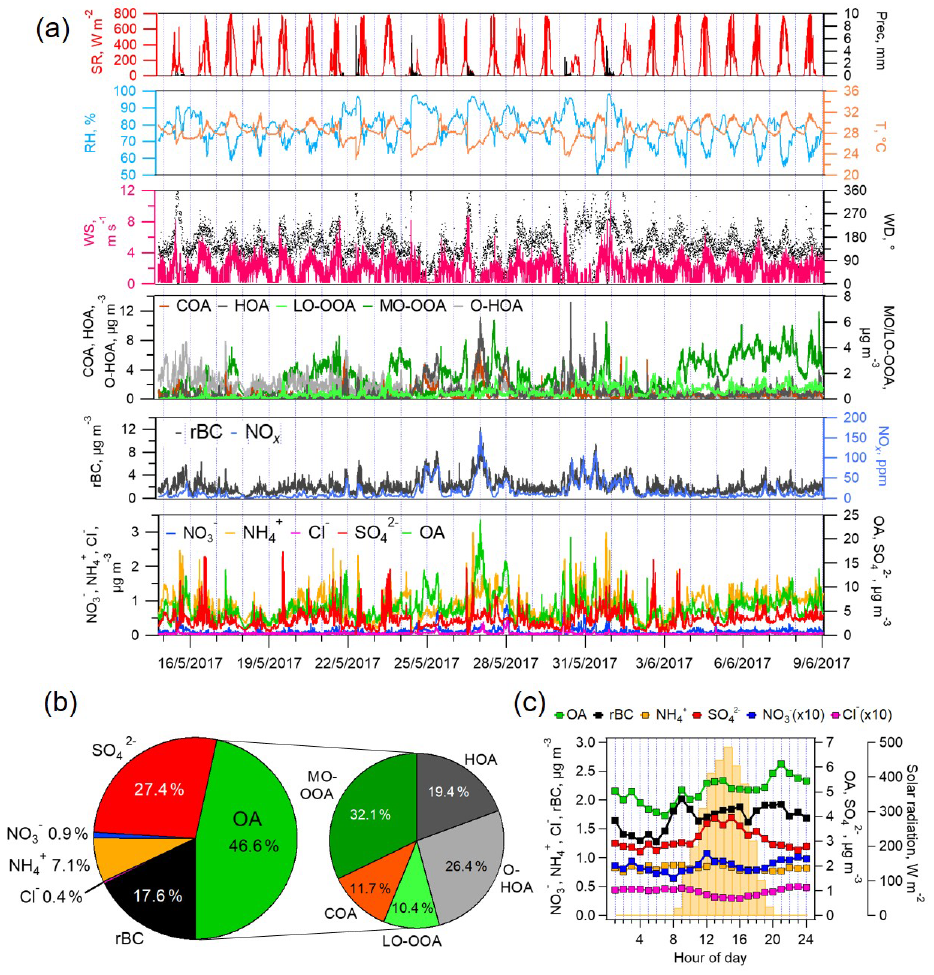
Figure 1. (a) Time series of solar radiation (SR), precipitation, temperature, relative humidity, wind speed (WS) and direction (WD), PMF factors (HOA, O-HOA, COA, LO-OOA, and MO-OOA from laser-off measurements), rBC, NO x , total OA, and inorganic species. (b) Aver- age chemical compositions of NR-PM and rBC with the contribution of the PMF factors to total OA. (c) Diurnal patterns of rBC, total OA, inorganic species, and solar radiation (represented by the yellow